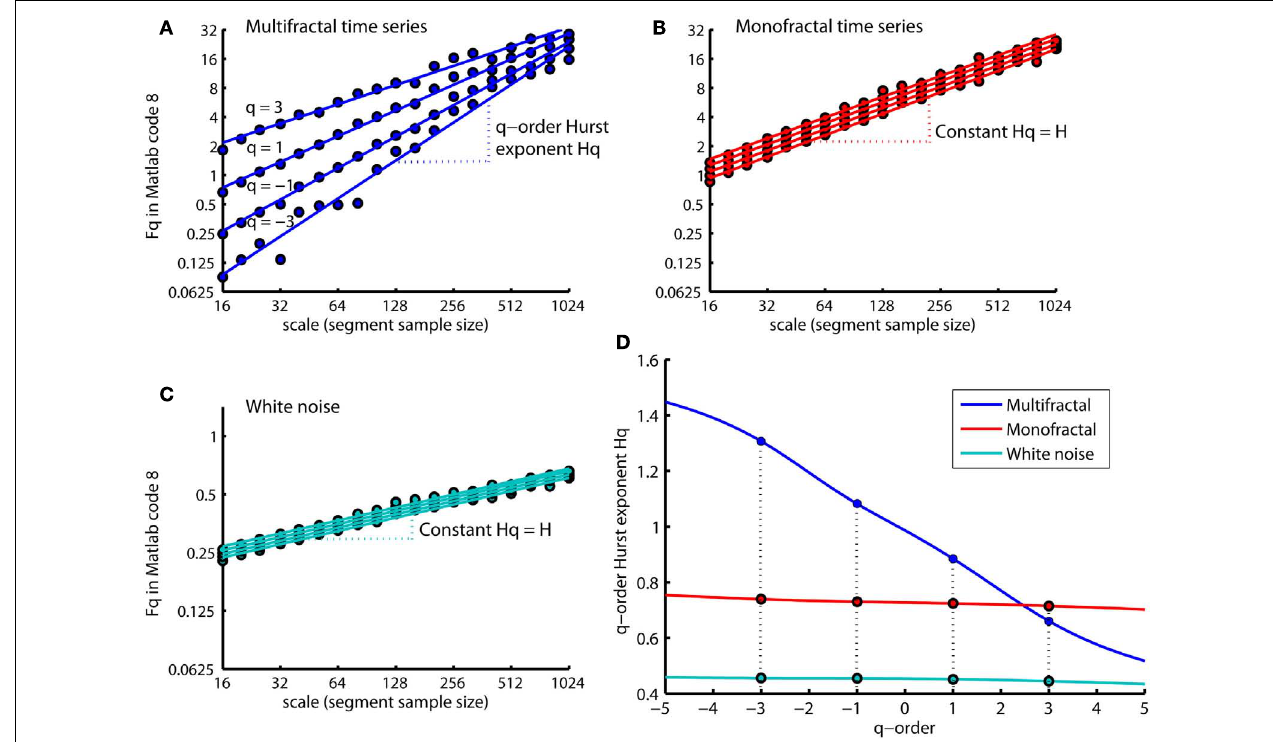
(D) The q -order Hurst exponent Hq for the time series multifractal ( blue trace ), monofractal ( red trace ) and whitenoise ( turqouish trace ) where the colored dots represents the slopes Hq for q =− 3, − 1, 1, and 3 illustrated in (A–C) . Notice that the intercept of Hq for multifractal and monofractal time series [intercept between blue and red trace in (D) ] are close to q = 2.This intercept reflects the similarity between their overall RMS, F , in Figure 5